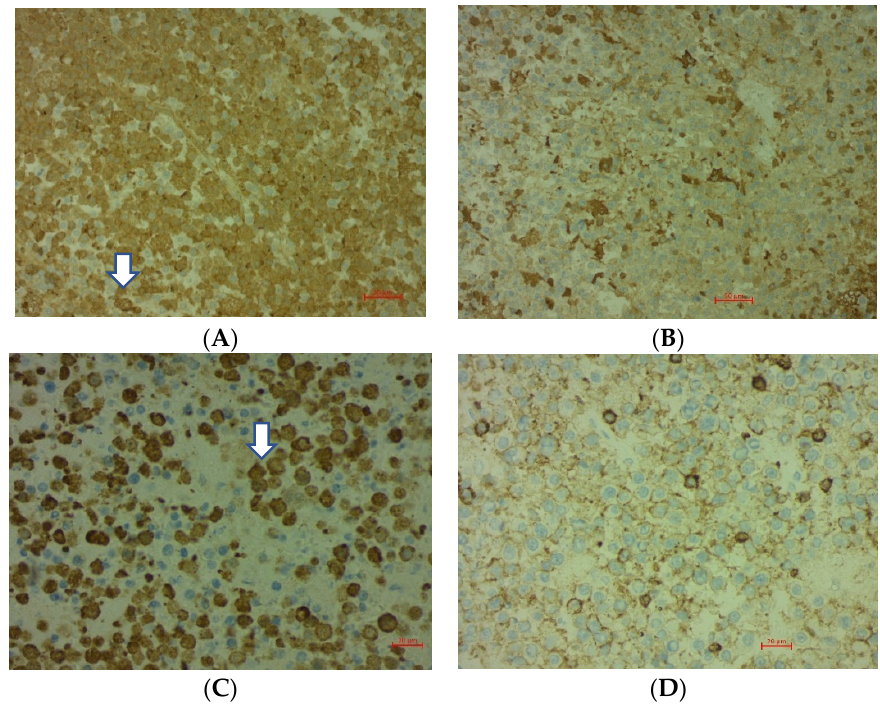
Figure 5. ( A ) kappa light chain immunoglobulin shows cytoplasmic expression (arrow); ( B ) a lack of the lambda immunoglobulin light chain. ( C ) Immunohistochemical staining for CD138 shows strong cytoplasmic positivity (arrow). ( D ) LCA.